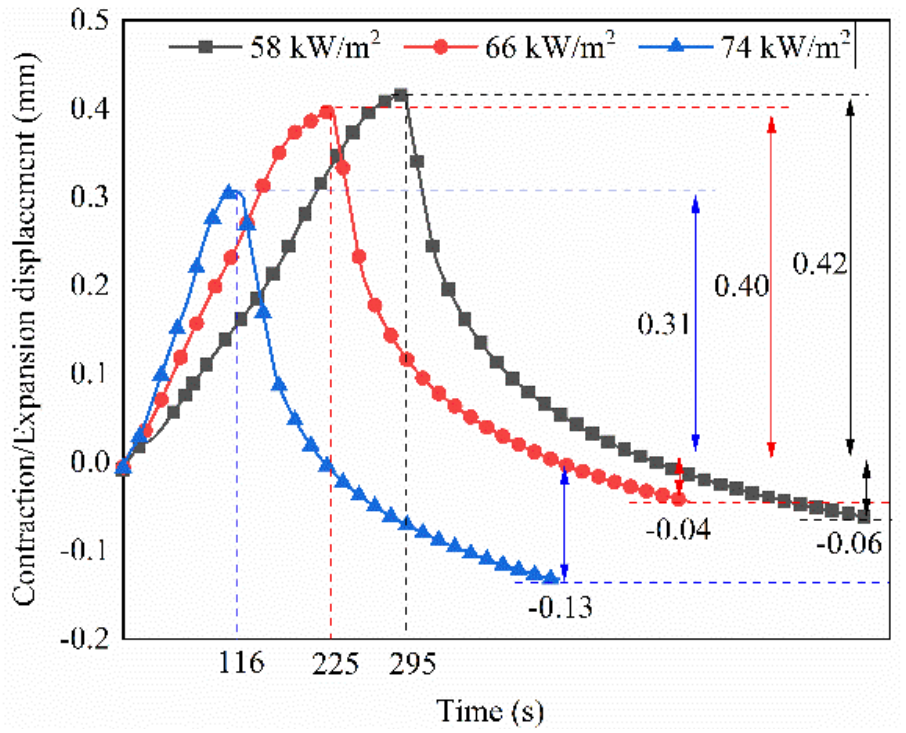
Figure 6. Displacement-time curves of welding specimens obtained with type B heating element at different power densities.